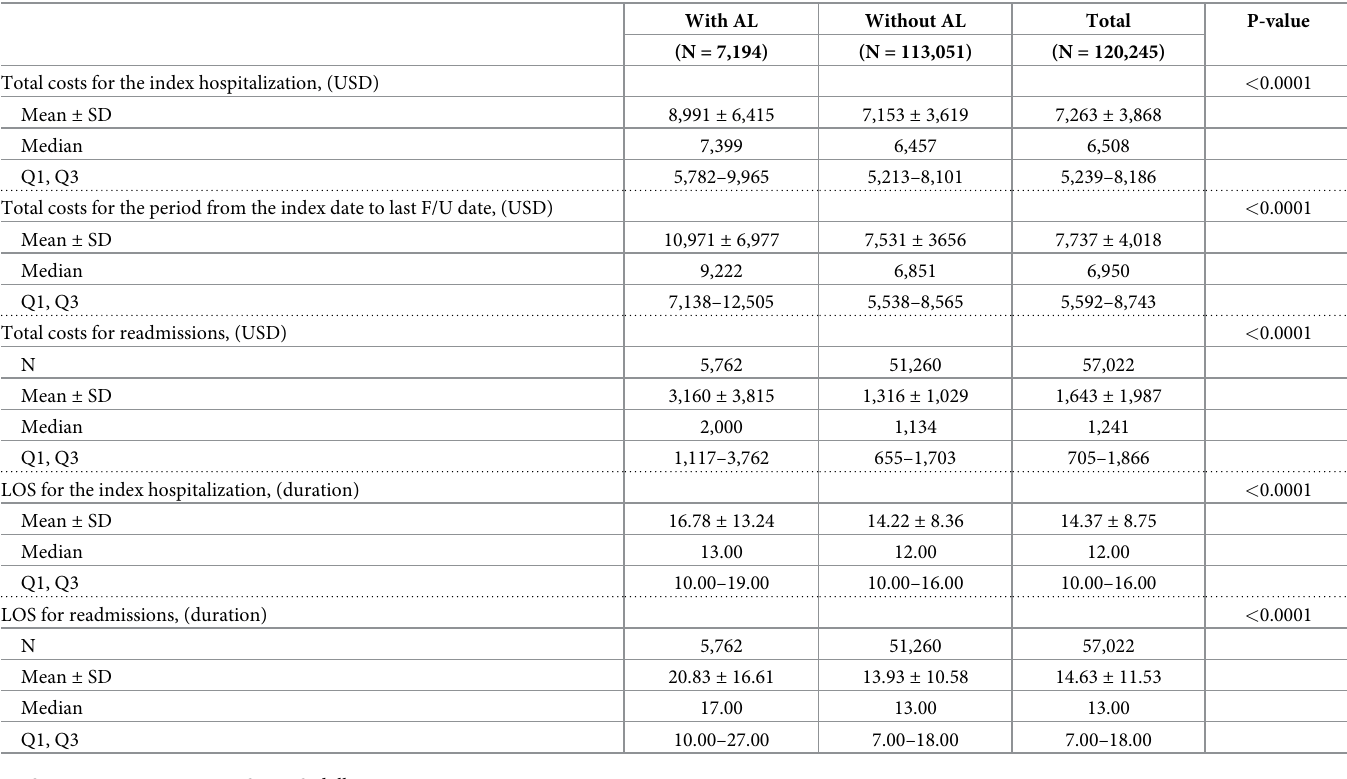
Table 5. Economic outcomes of the presence of anastomotic